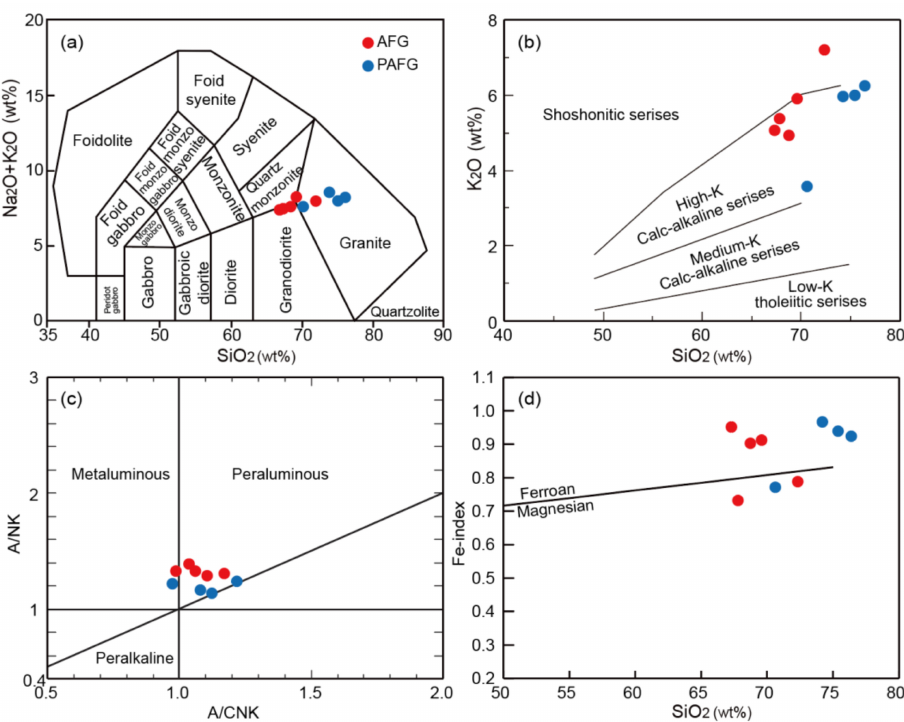
Figure 9. Geochemical classification diagrams for the Statherian granitoids. ( a ) Total alkali vs. SiO 2 diagram [41]. ( b ) K 2 O vs. SiO 2 diagram [42]. ( c ) Molar Al 2 O 3 /(Na 2 O + K 2 O) vs. Al 2 O 3 /(CaO + PAFG indicate alkali feldspar granite and porphyritic alkali feldspar granite, respectively.